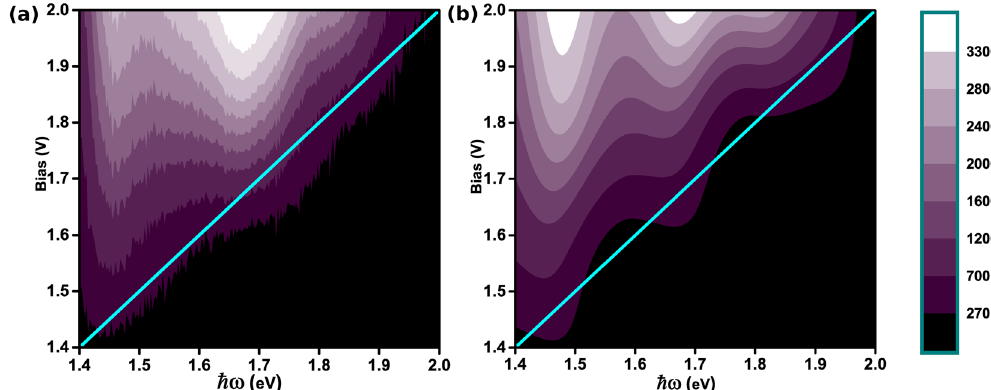
Figure 8. Contour plots of bias and energy dependent emission intensity from a Au-Au STM junction with constant tunnel current (~10 nA) ( a ) experimentally obtained from spectra in Fig. 1(a), and ( b ) theoretically calculated using P I ( ω ) (Equation (10)) (see Section I, Supplementary Information for further details). Scale bar indicates the emission intensity in false colour. Cyan line corresponds to eV b = ħ ω co which represents the limit of 1e